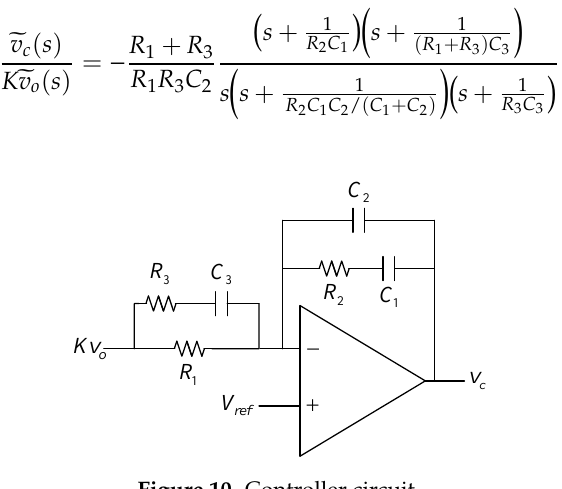
Figure 10. Controller circuit.